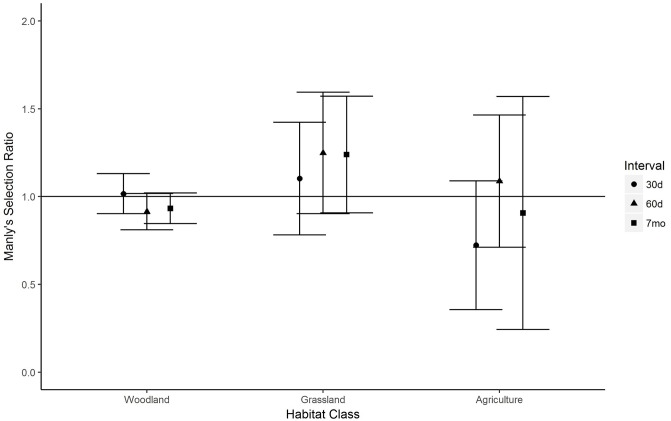
Habitat selection by male white-tailed deer fawns over intervals of 0–30 days post-capture, 0–60 days post-capture, and 0 days–7 months post-capture, Boone County, Iowa, USA, 2015–2017.Selection ratios >1 indicate selection for a habitat class, while ratios <1 indicate selection against a habitat class. Error bars represent 95% confidence intervals.